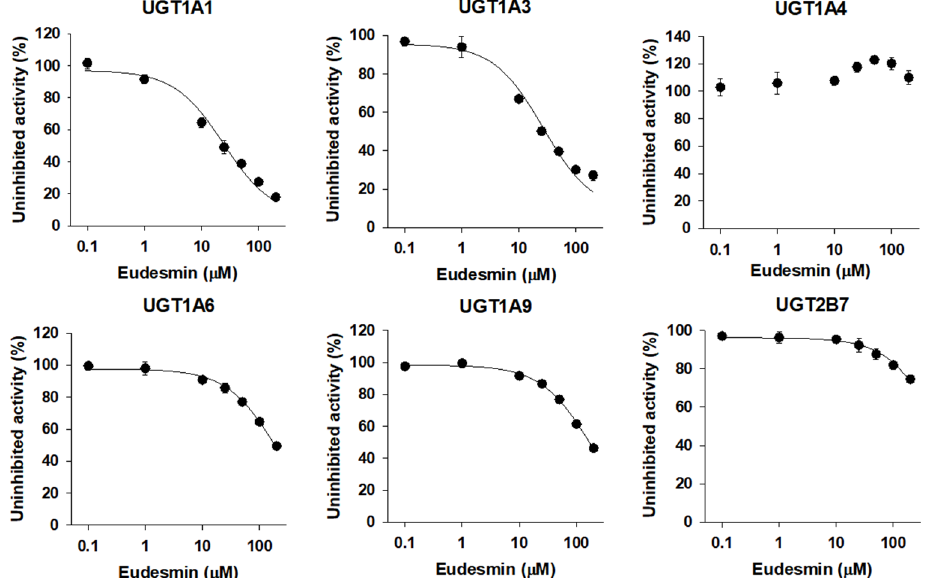
Figure 2. Inhibitory effects of eudesmin (0.1–200 μ M) on the UGT1A1-, UGT1A3-, UGT1A4-, UGT1A6-, UGT1A9-, and UGT2B7-mediated glucuronidation of 0.5 μ M SN-38, 2 μ M chenodeoxycholic acid, 0.5 μ M trifluoperazine, 1 μ M N -acetylserotonin, 0.2 μ M mycophenolic acid, and 1 μ M naloxone, a probe substrate for UGT1A1, UGT1A3, UGT1A4, UGT1A6, UGT1A9, and UGT2B7, respectively, in human liver microsomes. The data are expressed as means ± standard deviations ( n = 3).